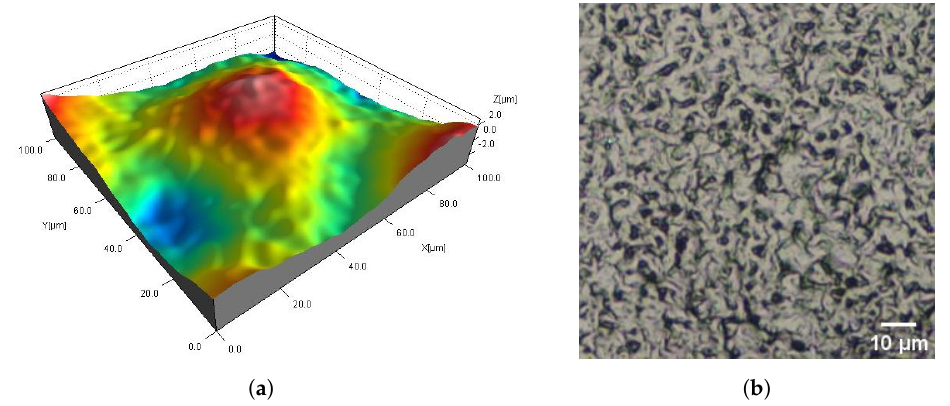
Figure 10. Fragment 0.1 mm × 0.1 mm of the SLS DM_VFS_Col sample surface: 3D map ( a ) and corresponding 2D view ( b ).